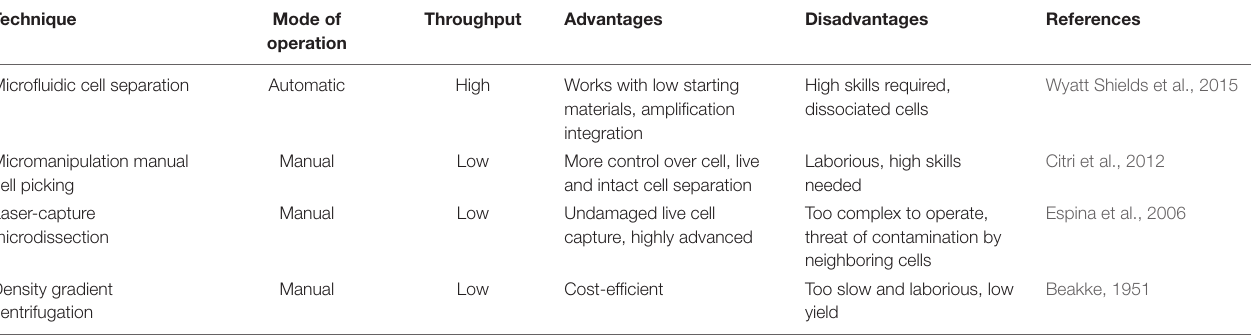
TABLE 3 | Commonly used methods for cell isolation on the bases of physical